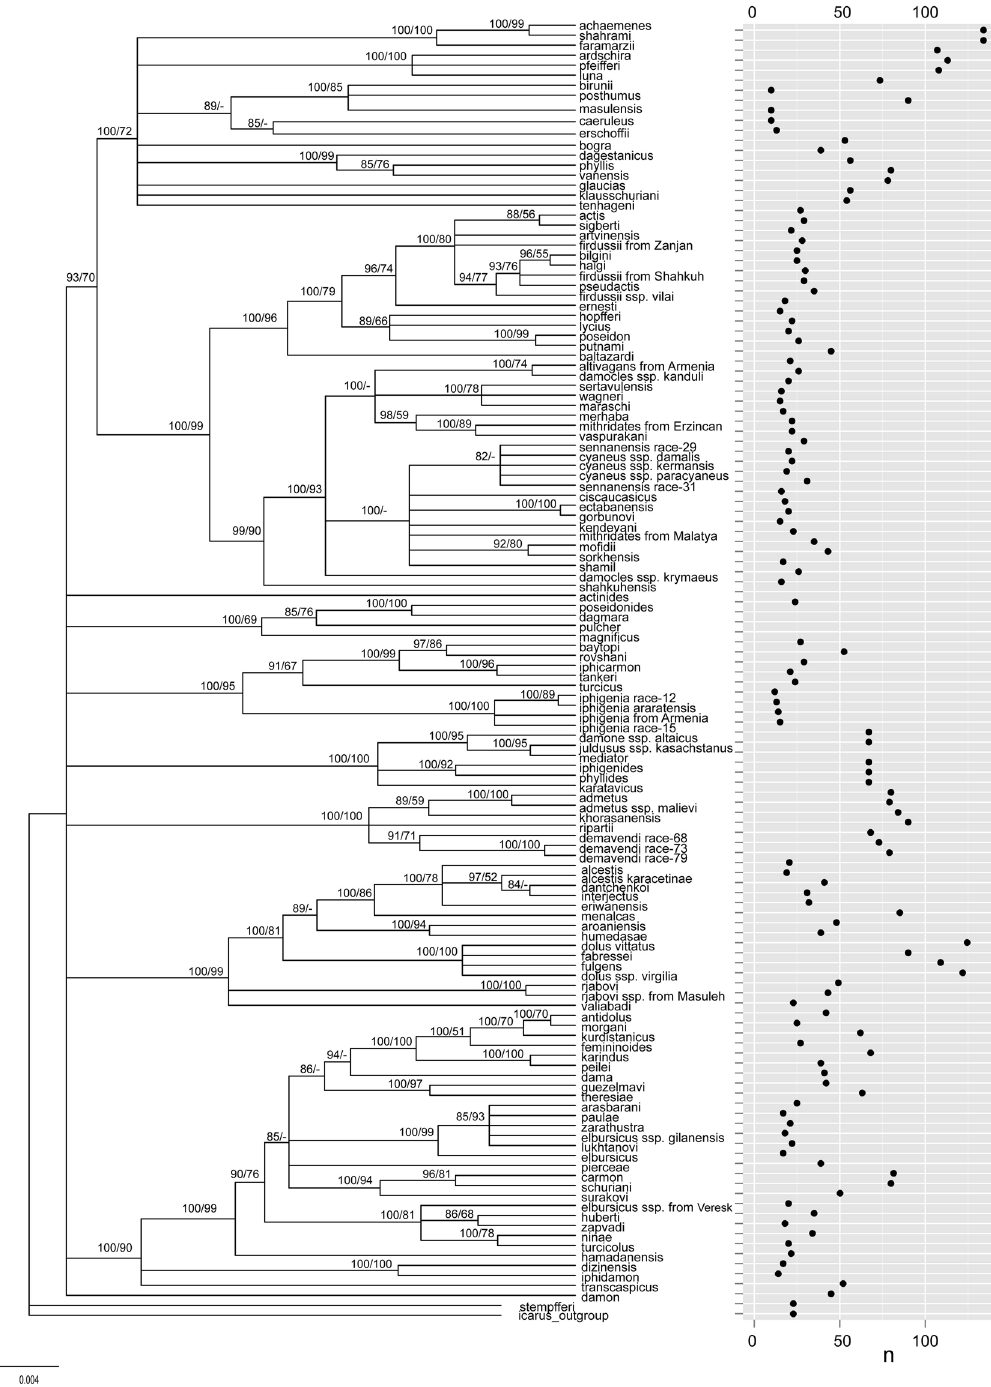
Figure 1. Bayesian majority rule consensus phylogram of seven nuclear and mitochondrial DNA markers for Agrodiaetus species. Numbers above the branches indicate Bayesian posterior probabilities and bootstrap support values for maximum likelihood tree (ML), in that order, expressed as percentages, dashes indicate support values below 50%. Dots on the plot represent haploid chromosome numbers